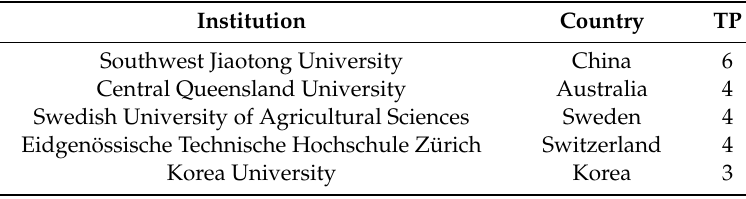
Table 4. Institutions with the most